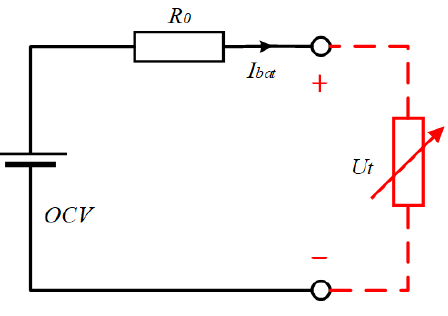
Figure 2. Rint circuit model.